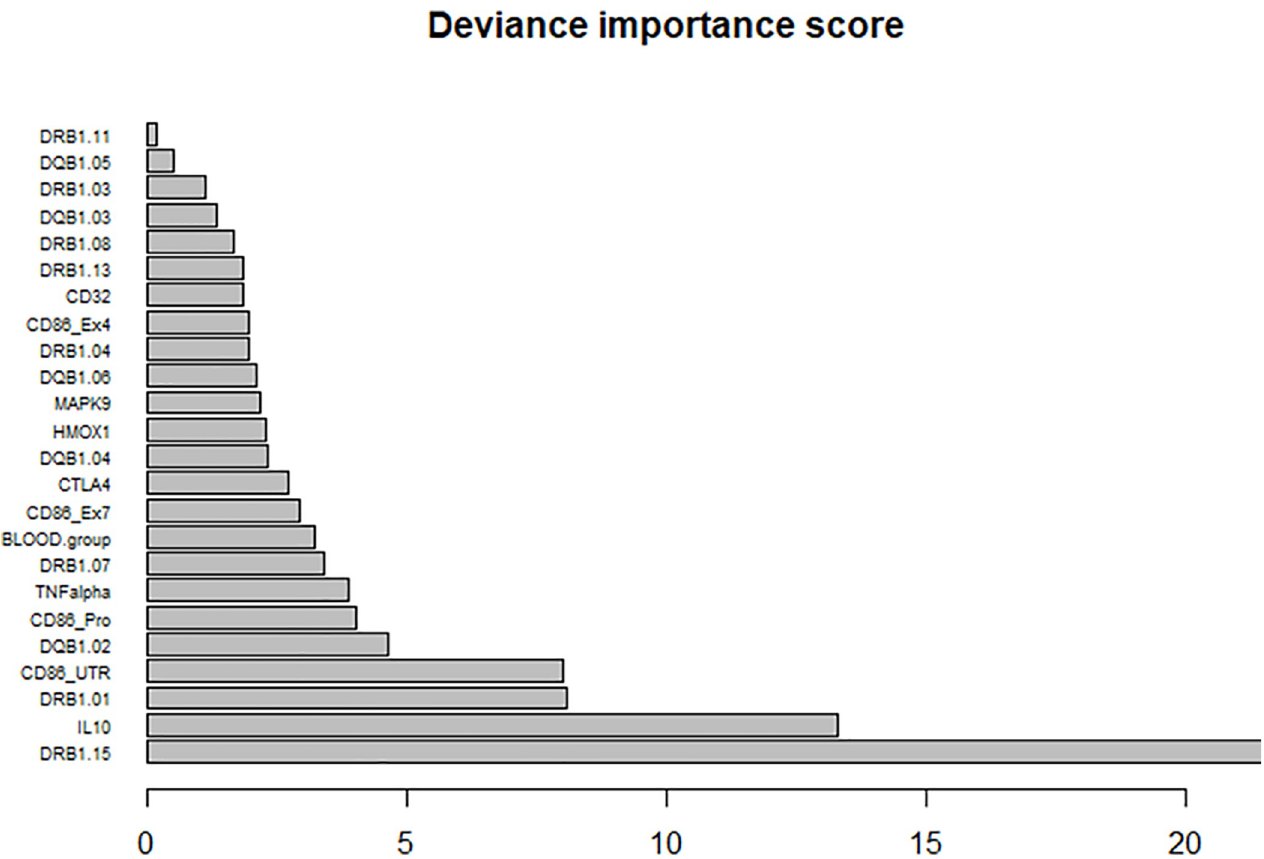
Fig 3. Deviance Importance Scores (DIS) obtained from bagged GPLTR for each of the competitive variables included in the multivariate model.